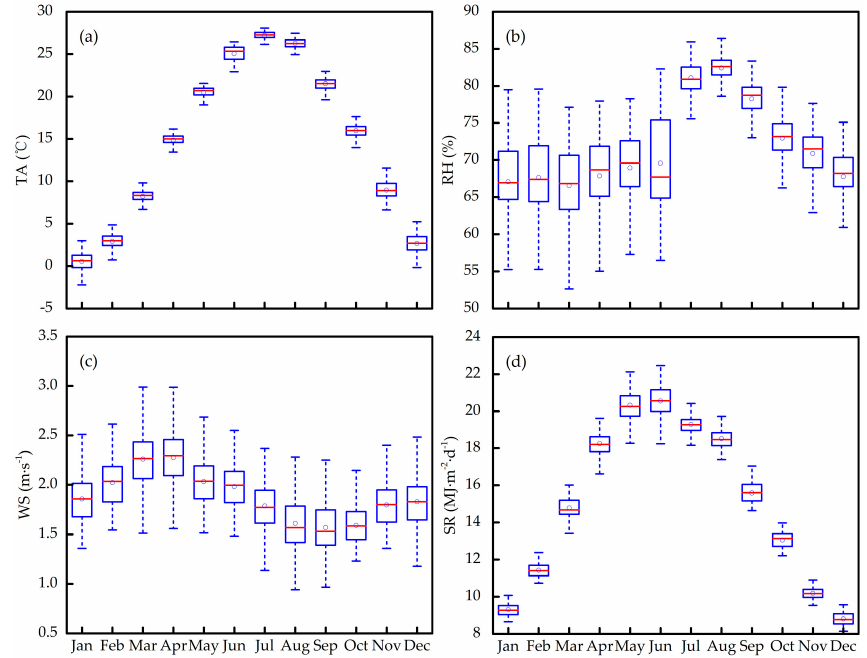
Figure 2. Box plots show the monthly variations of ( a ) TA ; ( b ) RH ; ( c ) WS ; and ( d ) SR in the HRB.